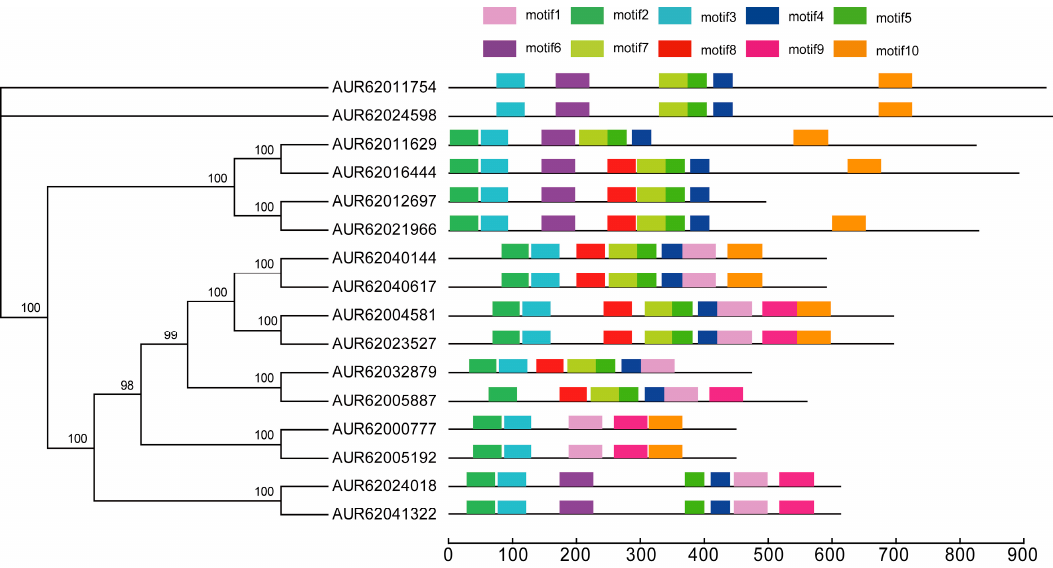
Figure 3. Conserved motifs across all CqHSP70s. Ten conserved motifs in all CqHSP70s were identified through the multiple EM for motif elicitation (MEME) analysis. Schematic representation shows conserved motifs and each motif is represented by a colored box numbered at the top. Scale bar indicates number of amino acids (aa).